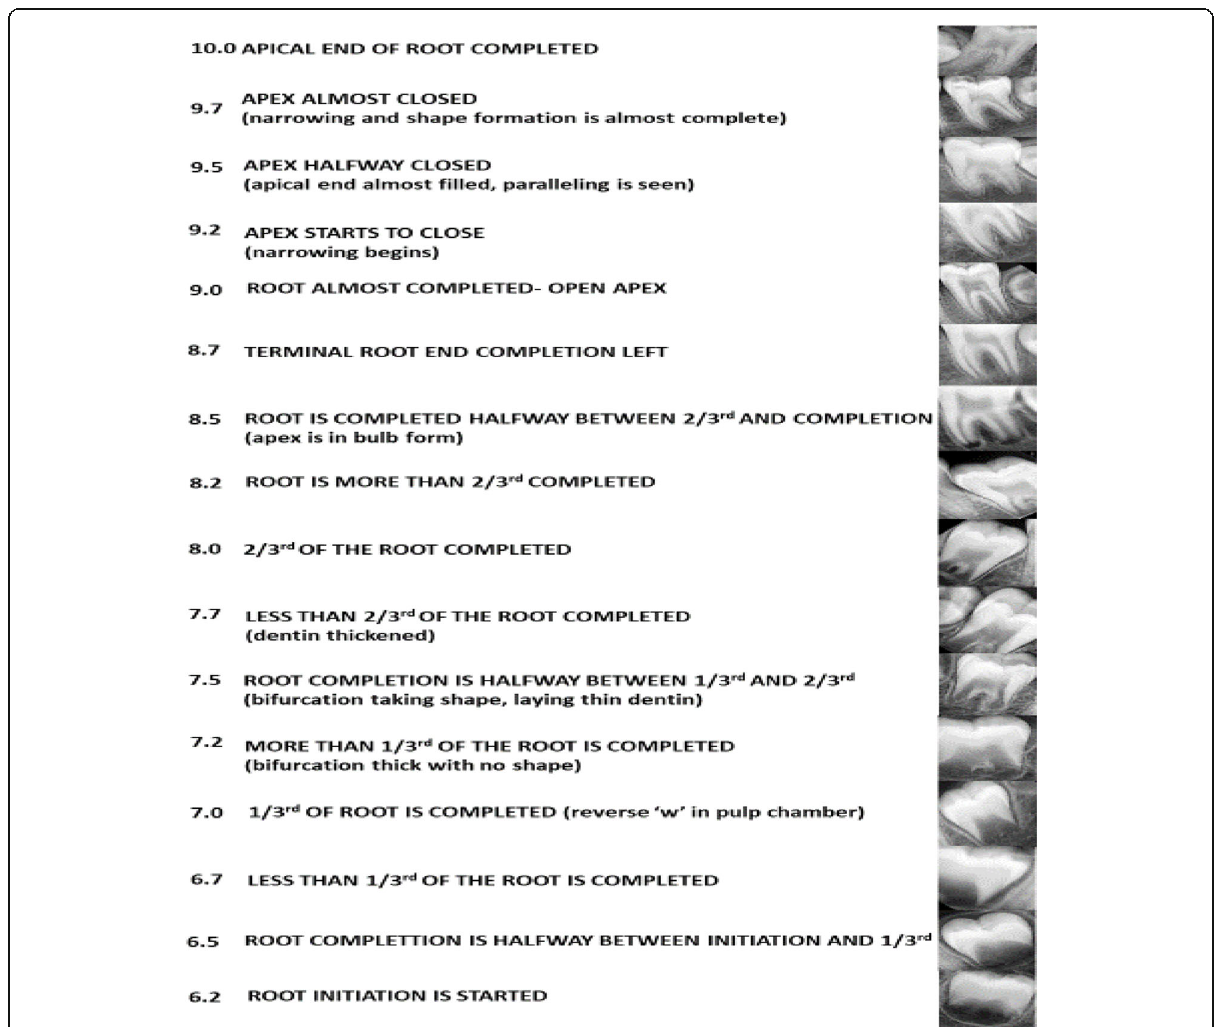
Fig. 4 Proposed substages for Nolla ’ s staging method drawn out from the study on North Indian